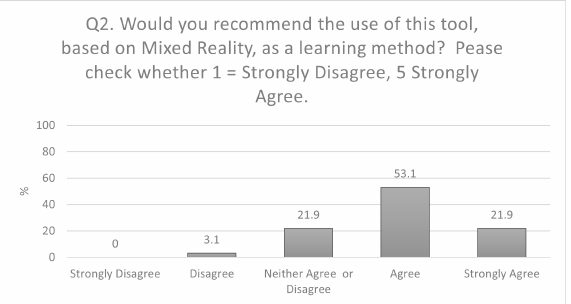
Figure 7. Results of Question 2 of Users Subjective Evaluation Questionnaire: users recommendation of Suture MR Tool usage for learning.